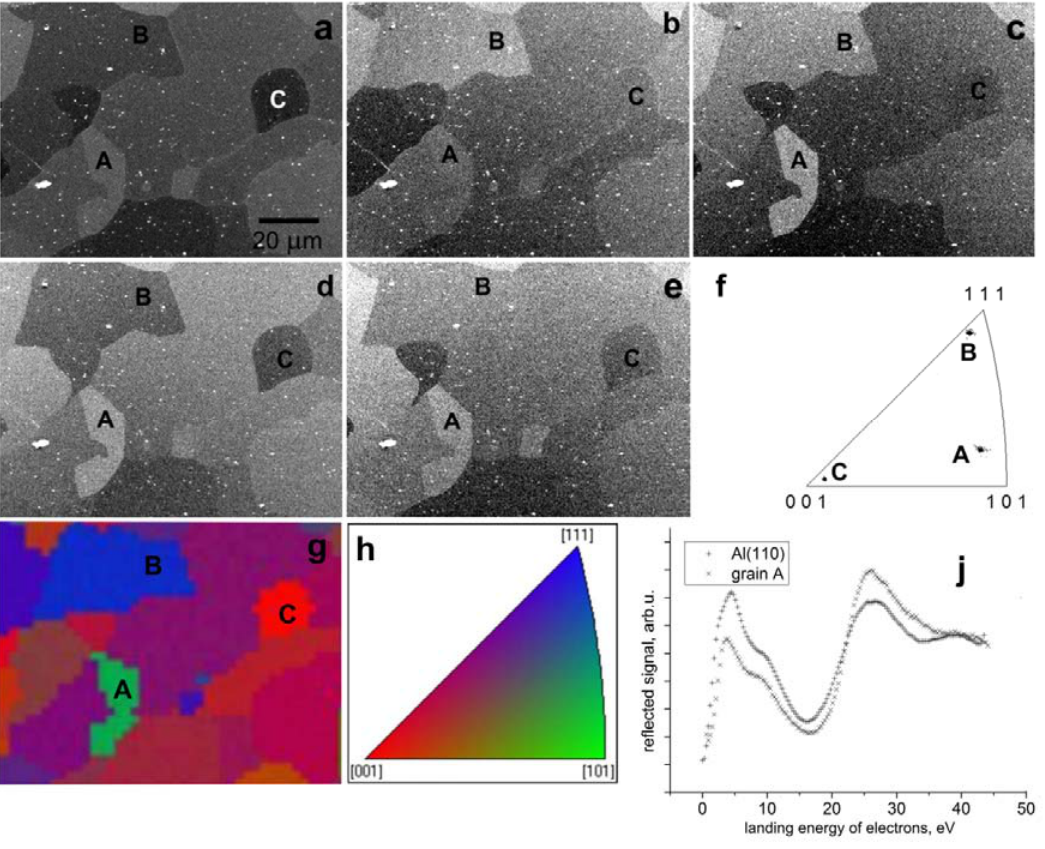
Figure 19. In-situ cleaned polycrystalline aluminum with three grains labeled A to C, imaged at very low energies. ( a ) 7.8 eV; ( b ) 17.4 eV; ( c ) 24.6 eV; ( d ) 30.9 eV; ( e ) 40.8 eV; ( f ) EBSD inverse pole map showing grains A to C; ( g ) EBSD mapping of the same area. ( h ) Color coding triangle; ( j ) Comparison of reflectances from the (110) single crystal and grain